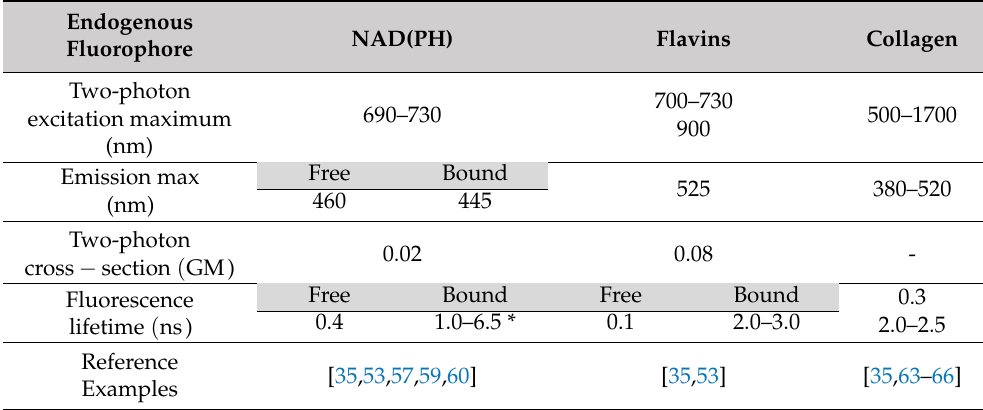
Table 1. Fluorescence properties of endogenous fluorophores present in the